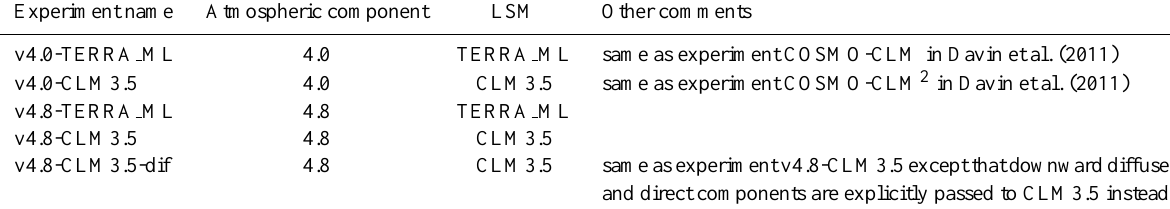
Table 1. Summary of the different experiments analysed in this study